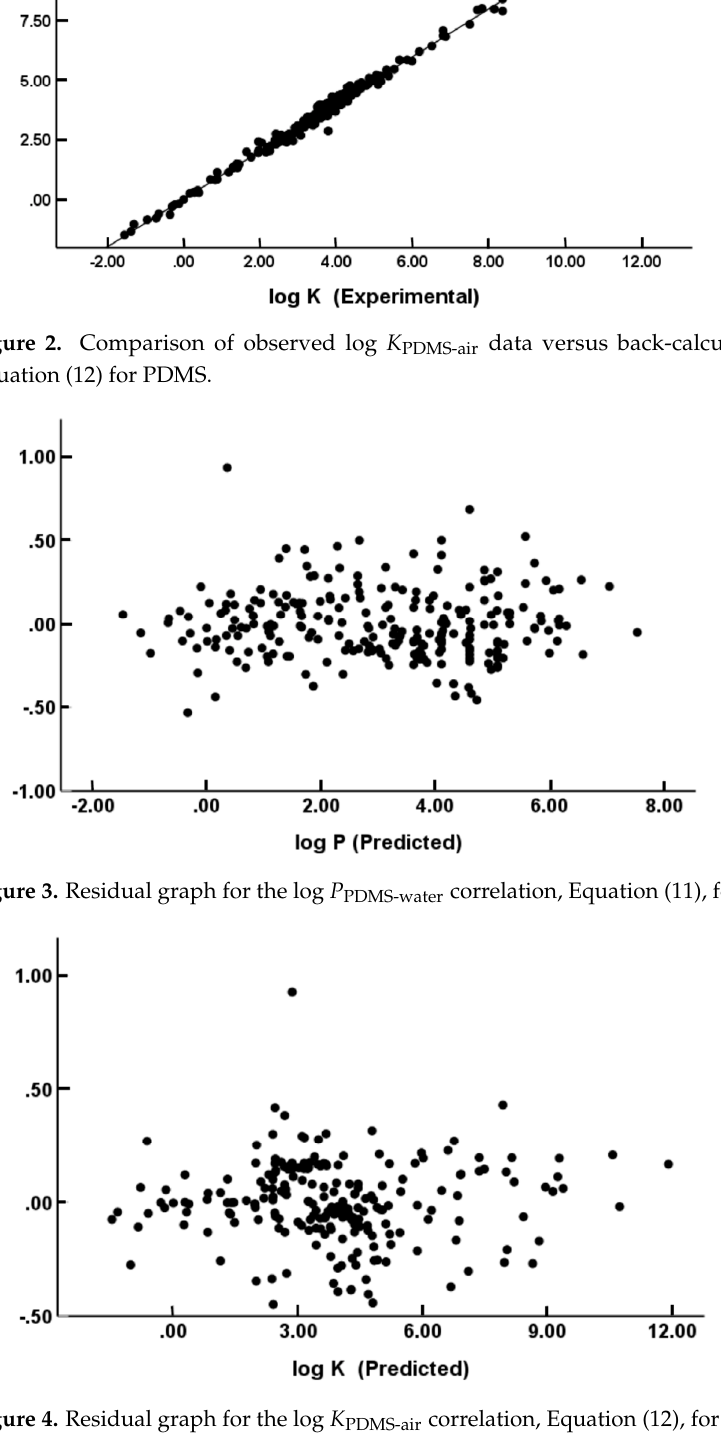
Figure 4. Residual graph for the log K PDMS-air correlation, Equation (12), for PDMS.